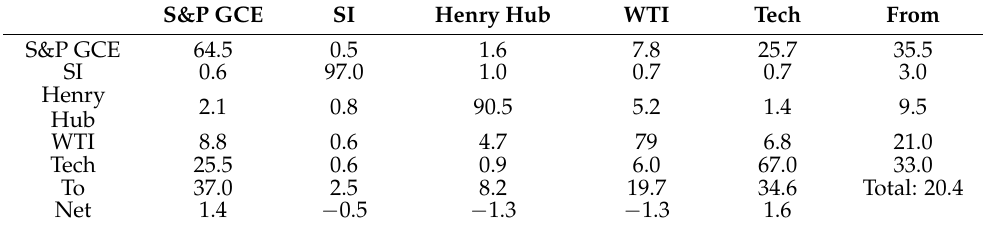
Table 2. Average dynamic return connectedness.